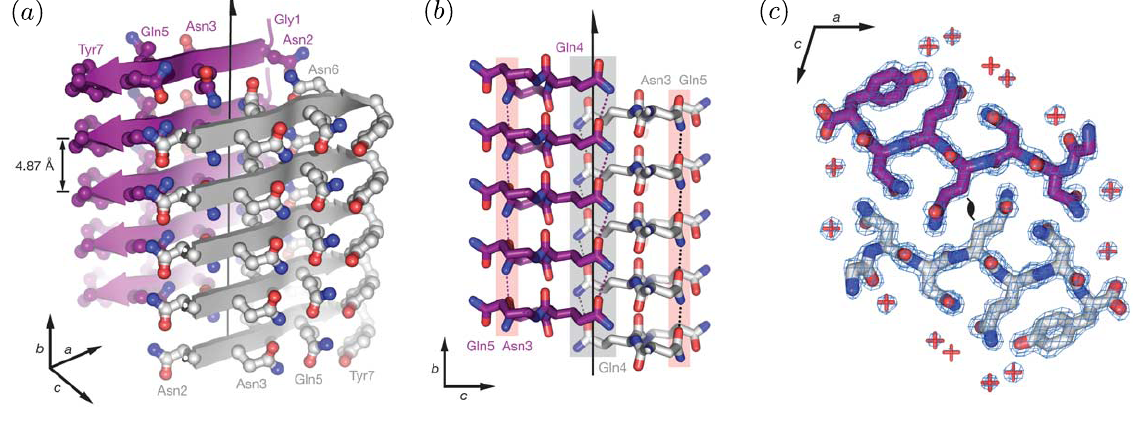
Figure 3. Cartoon illustrations of an A β protofibril are shown. Left : Looking down the axis of the fibril ( z -axis); Right : A sideview of the protofibril illustrating the twisted, helical pattern. Proteins are spaced at ≈ 5 ˚A, and the chiral twist of 0.833 degree/ ˚A was arbitrarily chosen for illustrative purposes. Image reprinted from Petkova et al. [50].